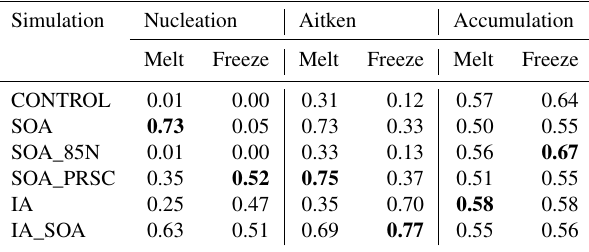
Table 3. Overlap indices calculated for the PDFs of nucleation, Aitken and accumulation aerosol concentrations from observations, and each simulation, measured at the surface. PDFs are separated into the melt and freeze periods before overlap indices are calcu- lated. Bold text indicates the greatest overlap index in each mode for the melt and freeze